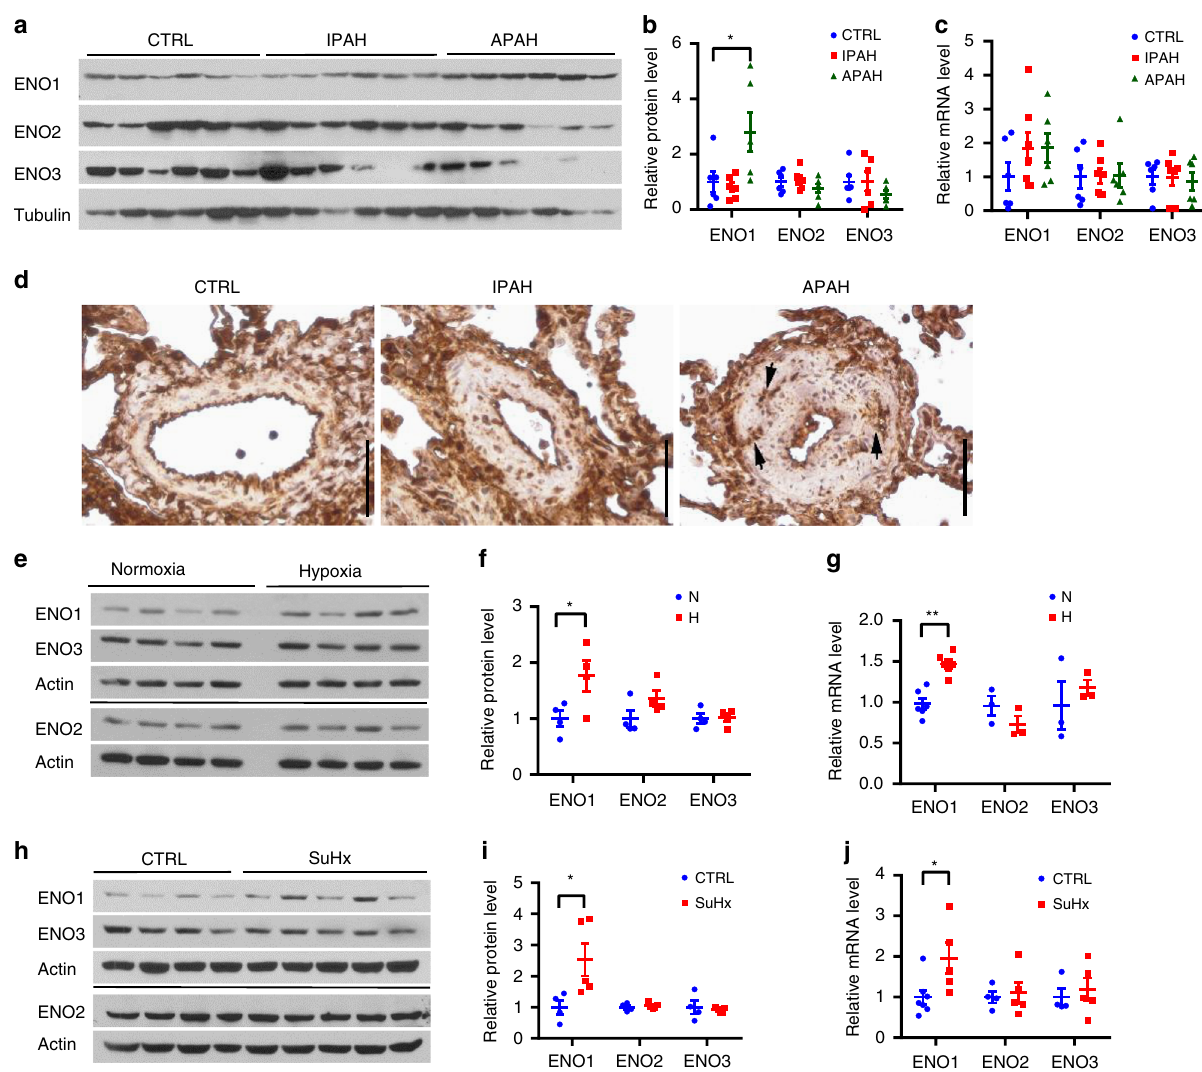
Fig. 1 Increased expression levels of ENO1 in hypertensive APAH patients and experimental PH animal lungs. a PASMC isolated from patients with IPAH or APAH and control donors were lysed and subjected to western blotting to measure the level of enolases. b Normalized quanti fi cation of proteins demonstrates the expression level of ENO1, ENO2, and ENO3 in PASMC isolated from patients with IPAH or APAH and control donors ( n = 6 per group, * P = 0.0223). c mRNA levels of ENO1, ENO2, and ENO3 in PASMC from patients with PAH and the control donors. d Immunohistochemistry of ENO1 in lung tissue sections of patients with PAH and the control donors. Brown color indicates the staining of ENO1. Black arrows indicate the elevated of ENO1 staining in the PASMC layer of the vessels (scale bars, 100 μ m). e Whole lung tissues were isolated from hypoxia-induced PH mice and western blotting was used to measure the level of enolases. f Normalized quanti fi cation of proteins demonstrates the expression level of enolases in the whole lung tissue of hypoxia-induced PH mice ( n = 4 per group, * P = 0.0263). g mRNA levels of enolase in the whole lung tissue of hypoxia-induced PH mice ( n = 3 – 6, P < 0.001). h Whole lung tissues were isolated from SuHx-induced PH rats and western blotting was used to measure the level of enolases. i Normalized quanti fi cation of protein demonstrates the expression level of enolases in the whole lung tissue of SuHx-induced PH rats ( n = 4 – 5 per group, test and one-way ANOVA were used to compare two and multiple groups. Bonferroni post-tests were carried out after